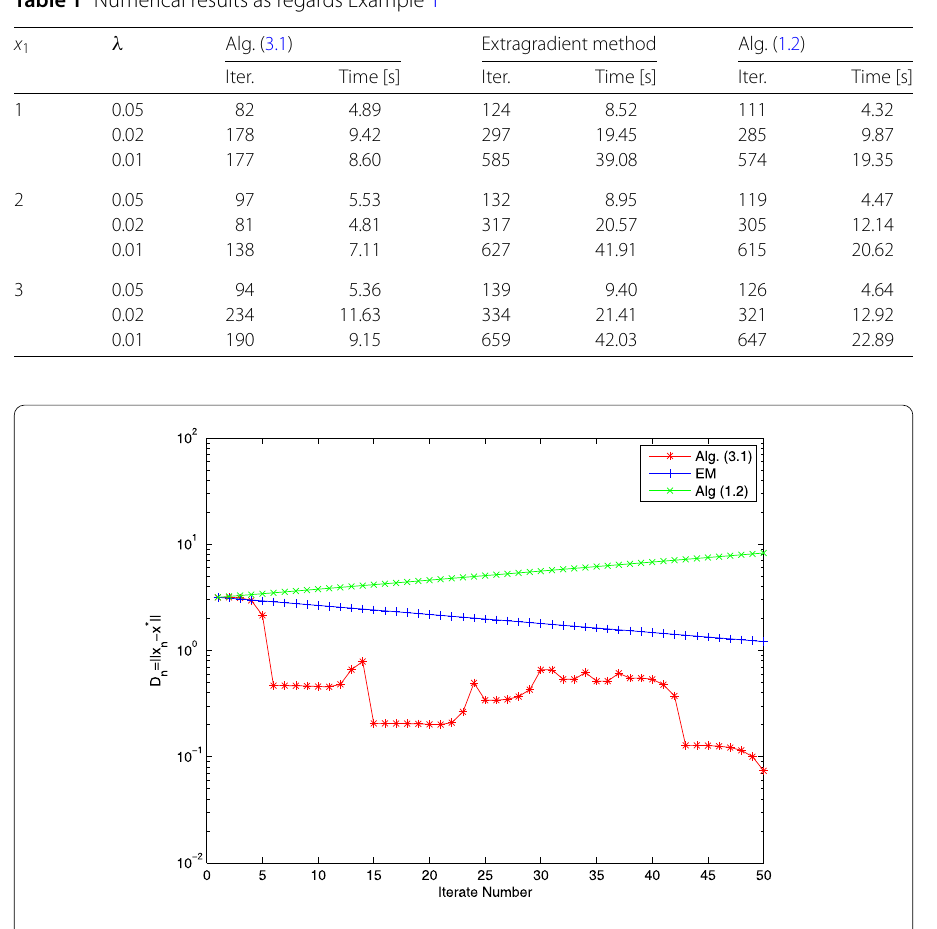
Figure 1 Numerical results as regards Example